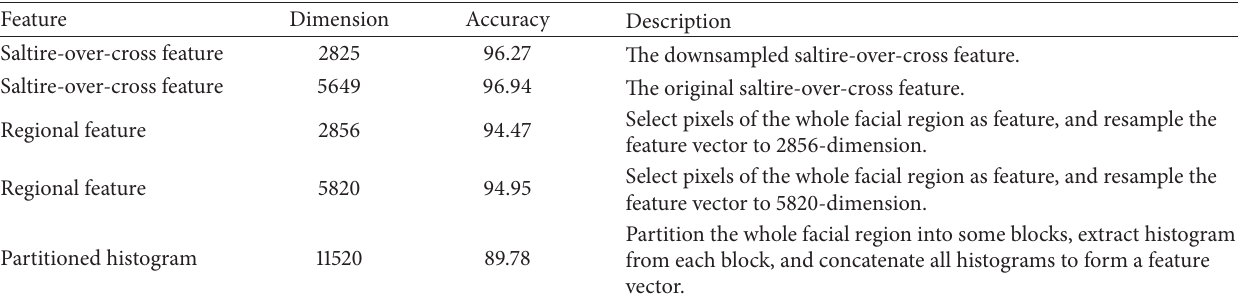
Figure 6: A representative face under 13 illuminations. Table 1: Comparison of different